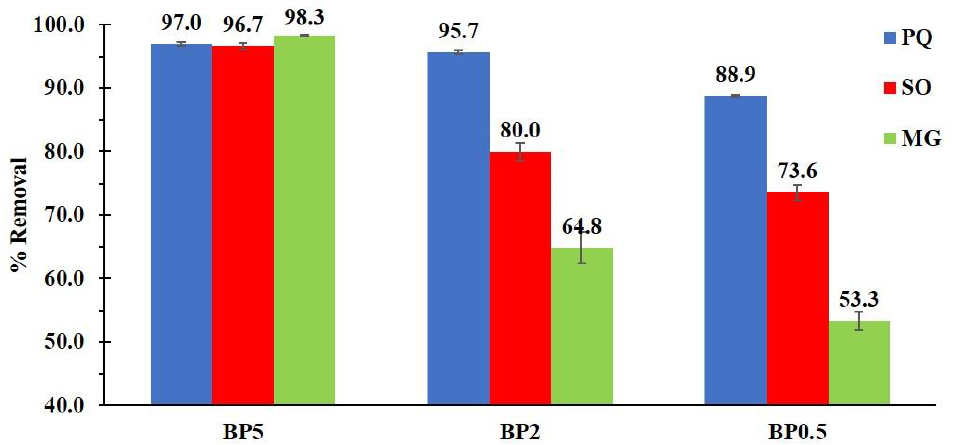
Figure 8. Influence of an amount of PVOH on the contaminant removal (conditions: 2 g/L of adsorbent dosage, optimal pH, 25 mg/L of initial concentration, 180 minutes of contact time and temperature at 303 K).